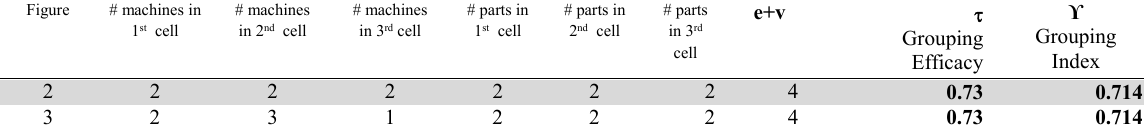
Evaluation of different measures for Fig. 1(efficiency of block-diagonal form)(q=0.5) Figure